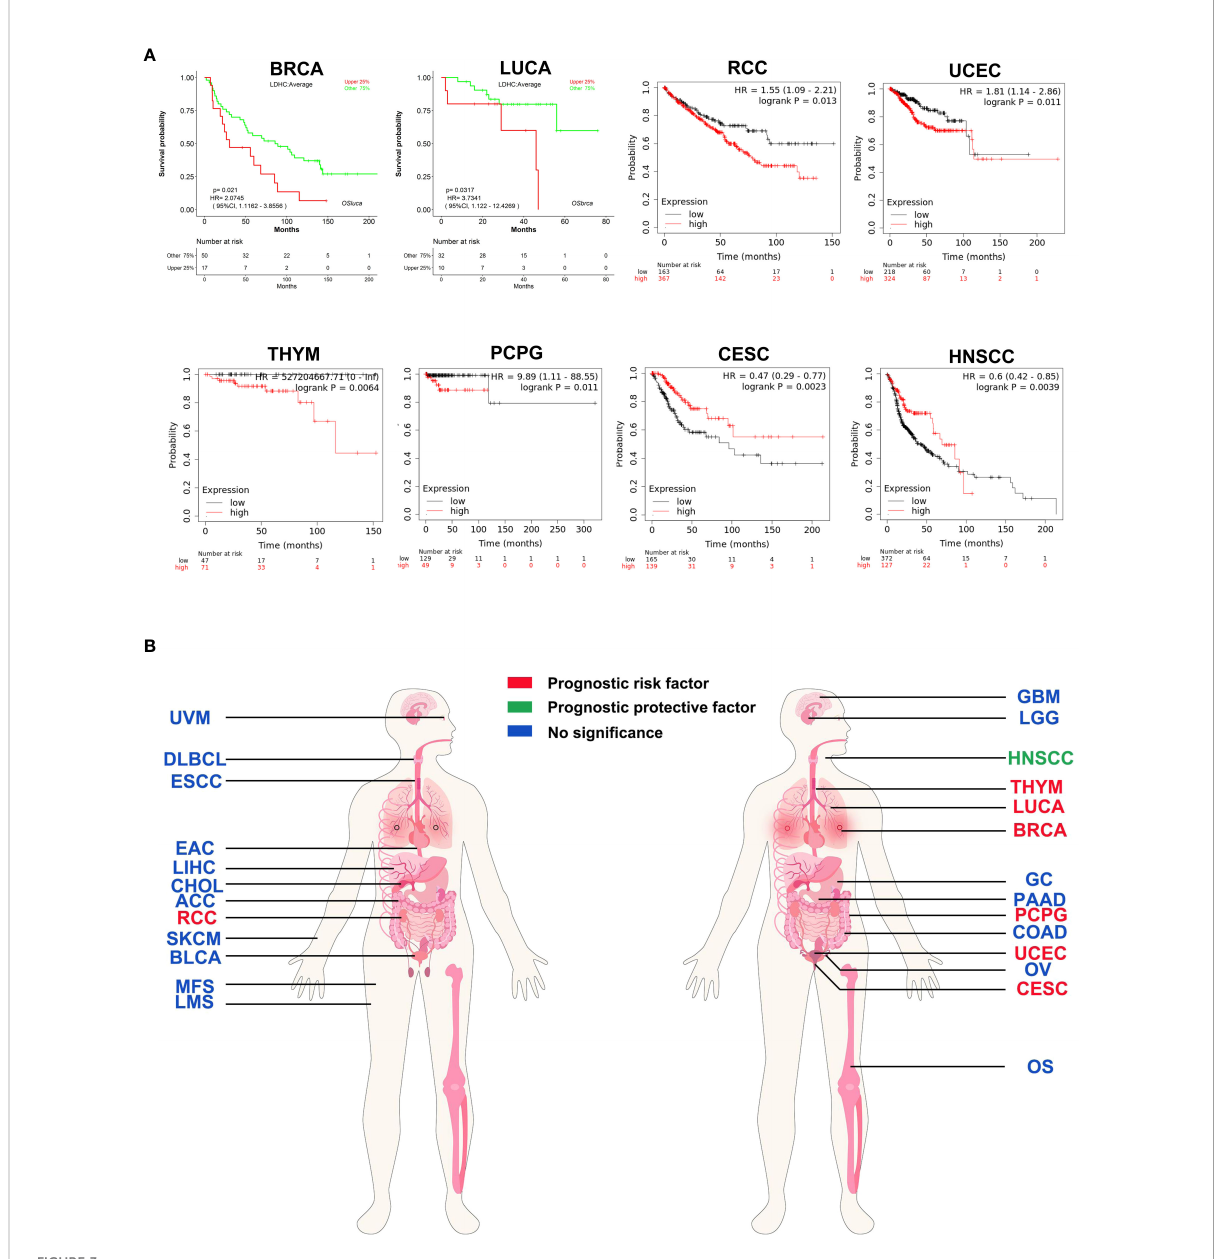
FIGURE 3 Prognostic pan-cancer analysis of LDHC using public databases. (A) Survival curves plotted using LOGpc and Kaplan – Meier plotter. (B) Pan- cancer view of the prognostic feature of LDHC based on the data from LOGpc and Kaplan – Meier plotter. The images of panel (B) are from the LOGpc database (https://bioinfo.henu.edu.cn/DatabaseList.jsp). ACC, adrenocortical carcinoma; BLCA, bladder urothelial carcinoma; BRCA, breast invasive carcinoma; CESC, cervical squamous cell carcinoma and endocervical adenocarcinoma; CHOL, cholangio carcinoma; COAD, colon adenocarcinoma; DLBC, lymphoid neoplasm diffuse large B-cell lymphoma; ESCA, esophageal carcinoma; GBM, glioblastoma multiforme; GC, gastric cancer; HNSCC, head and neck squamous cell carcinoma; RCC, renal cell carcinoma; LGG, brain lower-grade glioma; LIHC, liver hepatocellular carcinoma; LUCA, lung cancer; OS, osteosarcoma; OV, ovarian serous cystadenocarcinoma; PAAD, pancreatic adenocarcinoma; PCPG, pheochromocytoma and paraganglioma; SKCM, skin cutaneous melanoma; THYM, thymoma; UCEC, uterine corpus endometrial carcinoma; UVM, uveal